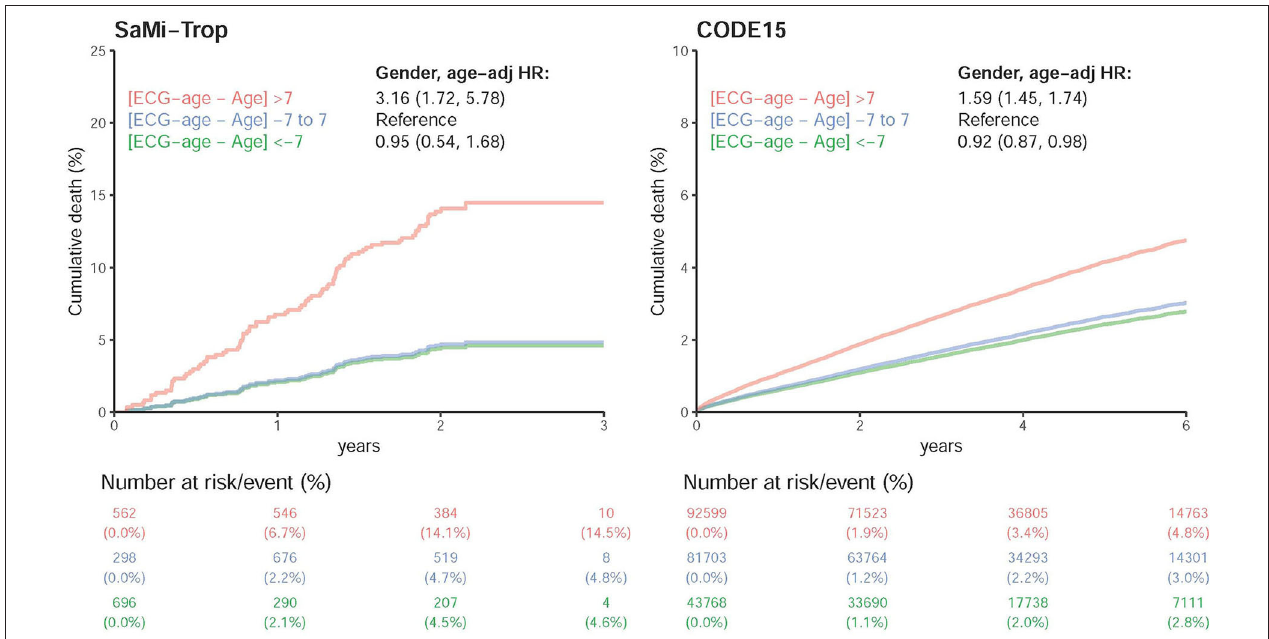
FIGURE 9 | Survival analysis in SaMi-Trop and CODE15 datasets. Cox proportional model for each risk stratification on all-cause mortality in SaMi-Trop and CODE15 datasets. The table shows the at-risk population and cumulative risk for the given time intervals in each risk stratification. Both of the patients are taken into consideration: those with ECG-age more than 7 years greater than the chronological age (denoted by: “ > 7 years older”); those with ECG-age within a range of 7 years from their chronological age (denoted by: “ ± 7 years”); and, those with ECG-age more than 7 years smaller than the chronological age (denoted by: “ > 7 years